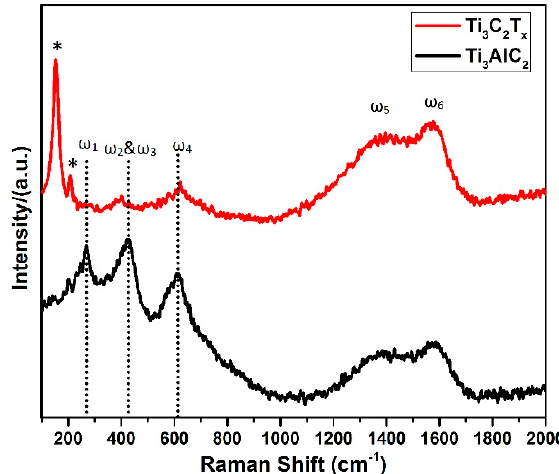
Figure 2. Raman Spectra of Ti 3 AlC 2 MAX powder and Ti 3 C 2 T x Mxene. Peaks marked with * are assigned to the out of plane vibrations of Ti and C atoms.